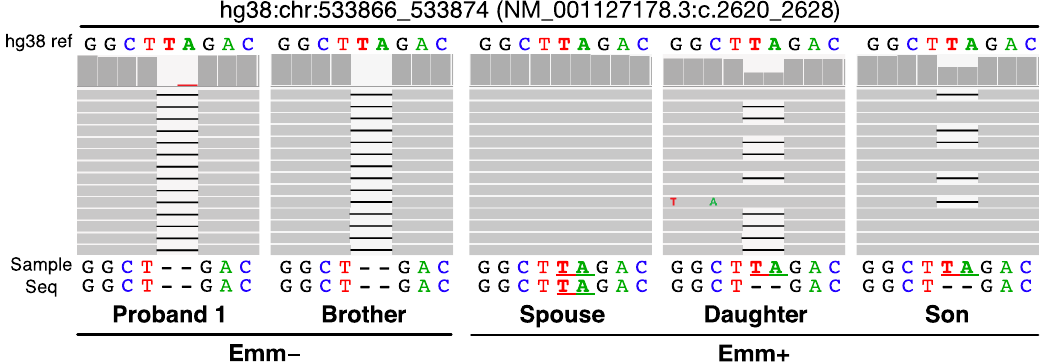
PIGG mutations in additional Emm− probands and breakpoint analysis. Samples from two unre- lated Emm− probands from our collections and from two generations of a North African family, consisting of 10 individuals, underwent genomic investigation by Sanger sequencing and targeted NGS of PIGG . Figure 2B shows the amplification products for the 13 PIGG Exons in a Emm+ control, and from Proband 2 and Proband 3. PIGG Exon 3 failed to amplify in Proband 2 and the weak product from Exon 1 and 2 suggested Exon 1 and/ or 2 involvement. For Proband 3, Exons 7, 8, and 9 failed to amplify. Long range amplification targeting Exons 1 and 4 in Proband 2’s sample (Fig. 2C) compared to a control confirmed the presence of a deletion in PIGG . Sequencing of the Exon 1–4 product using targeted NGS found a deletion of 6.0 kb spanning Exons 2 and 3 and identified breakpoint regions in Intron 1 and 3 [g.5982_11944del, p.(Ala53Glyfs*2)]. Sanger sequencing confirmed the specific breakpoint sequence (Fig. 2C).